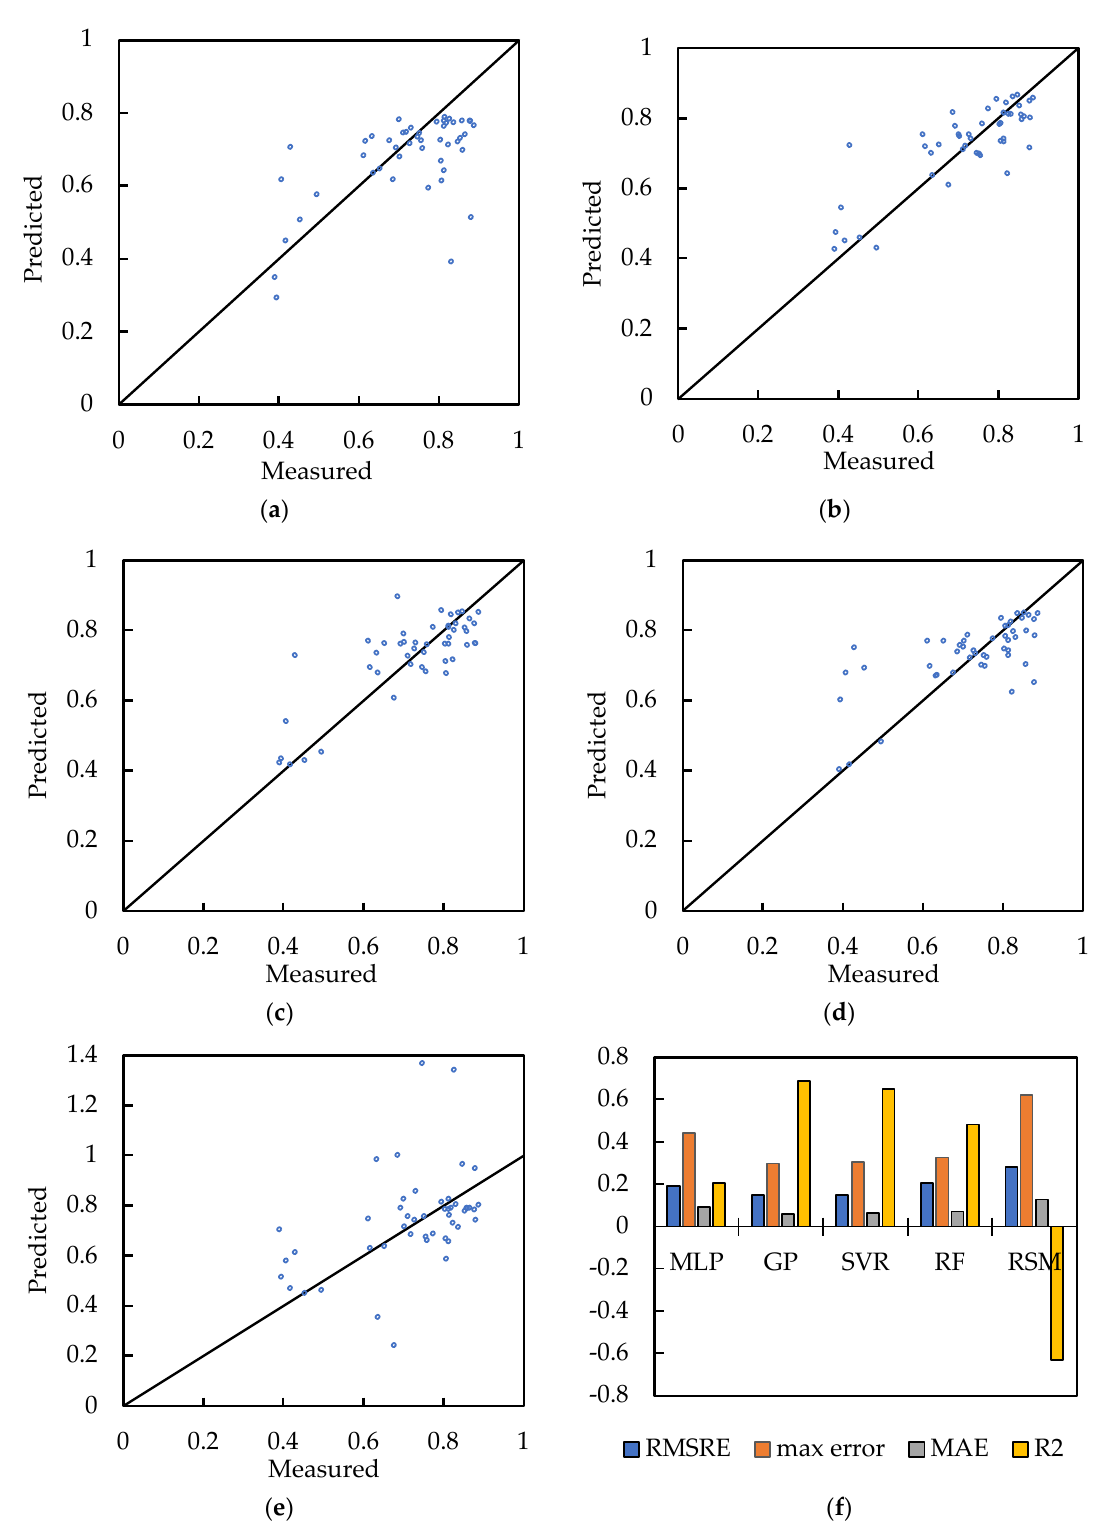
Figure 4. Prediction of fracture strain in the HET as a function of the respective measured value (illustrative example for one of the 15 cases analysed): ( a ) MLP; ( b ) GP; ( c ) SVR; ( d ) RF; ( e ) 2nd order polynomial regression; ( f ) performance metrics (see also Table 3). Table 3. Performance metrics values corresponding to Figure 4f.